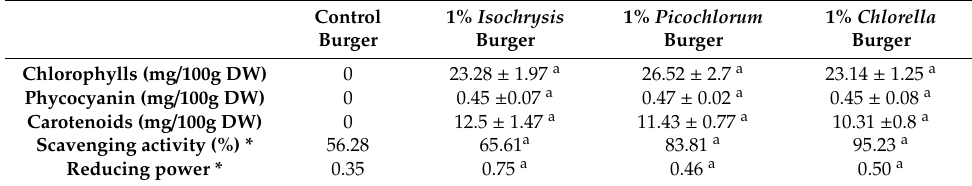
Table 6. Pigments content and antioxidant activities of control and microalgae-fortified burgers after production. Control 1% Isochrysis 1% Picochlorum 1% Chlorella Burger Burger Burger Burger Chlorophylls (mg / 100g DW) 0 23.28 ± 1.97 a 26.52 ± 2.7 a 23.14 ± 1.25 a Phycocyanin (mg / 100g DW) 0 0.45 ± 0.07 a 0.47 ± 0.02 a 0.45 ± 0.08 a Carotenoids (mg / 100g DW) 0 12.5 ± 1.47 a Scavenging activity (%) * 56.28